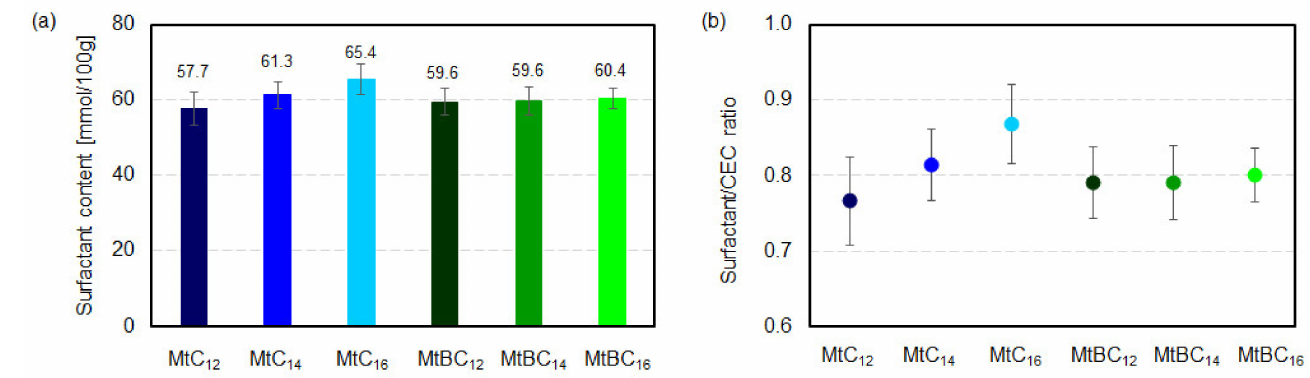
Figure 3. ( a ) Molar content of ammonium salts in organo-montmorillonite; ( b ) the ratio of surfactant in organo- montmorillonite to cation exchange capacity in raw